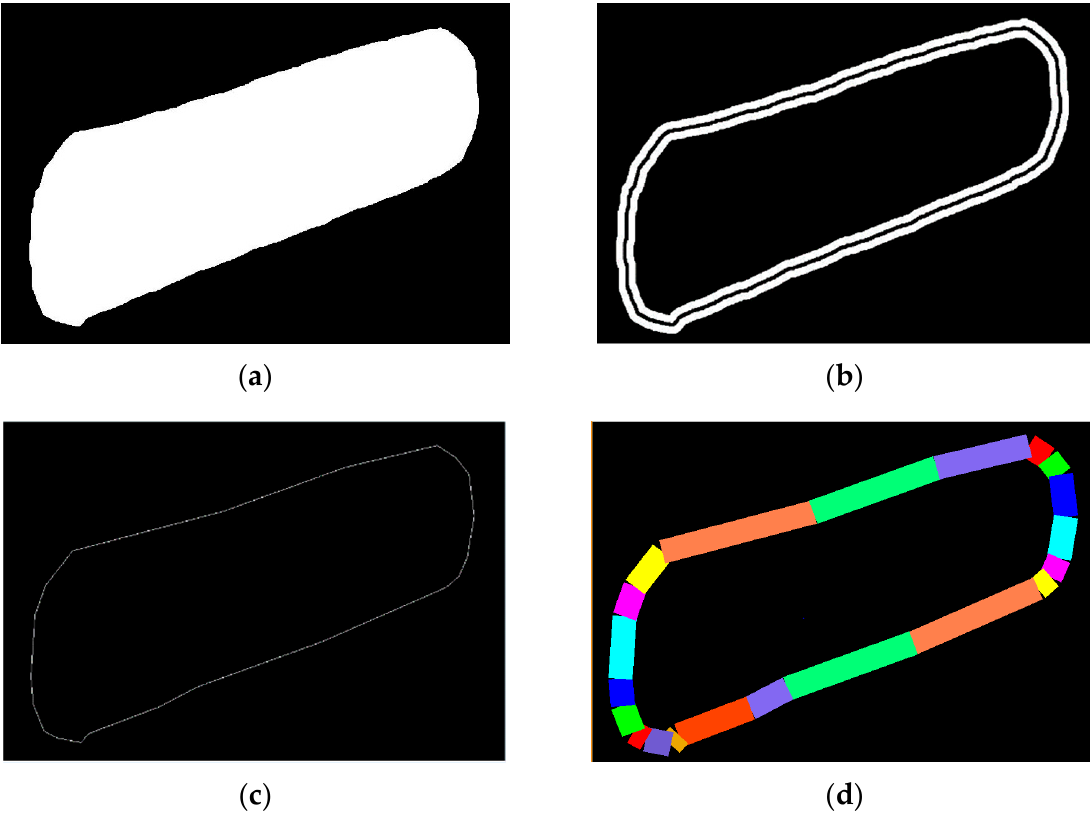
Figure 11. Region segmentation process with multi-neural network: ( a ) initial segmented region; ( b ) morphological processing result; ( c ) boundary polygon; ( d ) multi-neural network region.